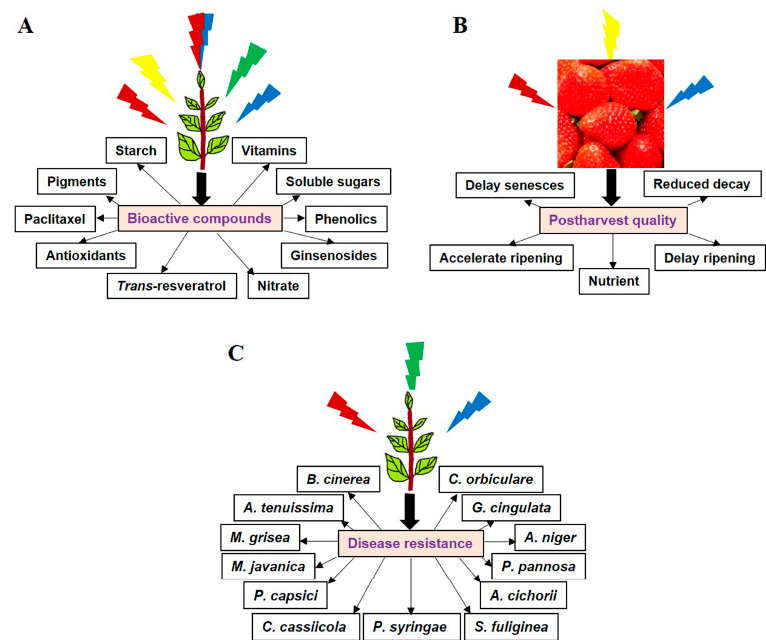
Figure 1. Effect of LEDs on ( A ) bioactive compounds production, ( B ) postharvest quality, and ( C ) disease resistance against different pathogens. For specific effects of LEDs on different plant traits, refer to the tables.